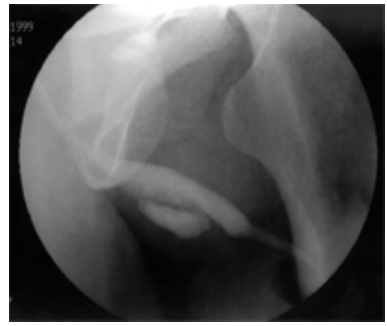
FIGURE 2. Micturating cystourethrogram showing a syringocele of Cowper's